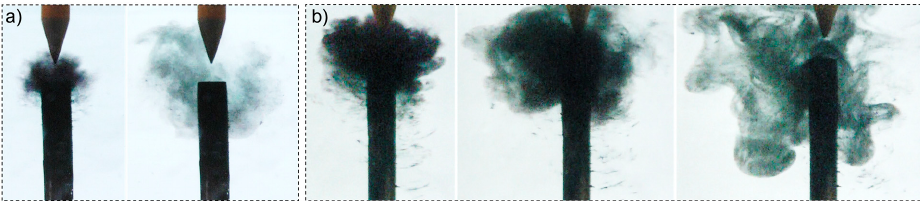
Figure 7. Release of materials from the cathode surface after switching off the power supply: ( a ) case 2 ( σ 0 = 8 µS/cm) and ( b ) case 4 ( σ 0 = 64 µS/cm).